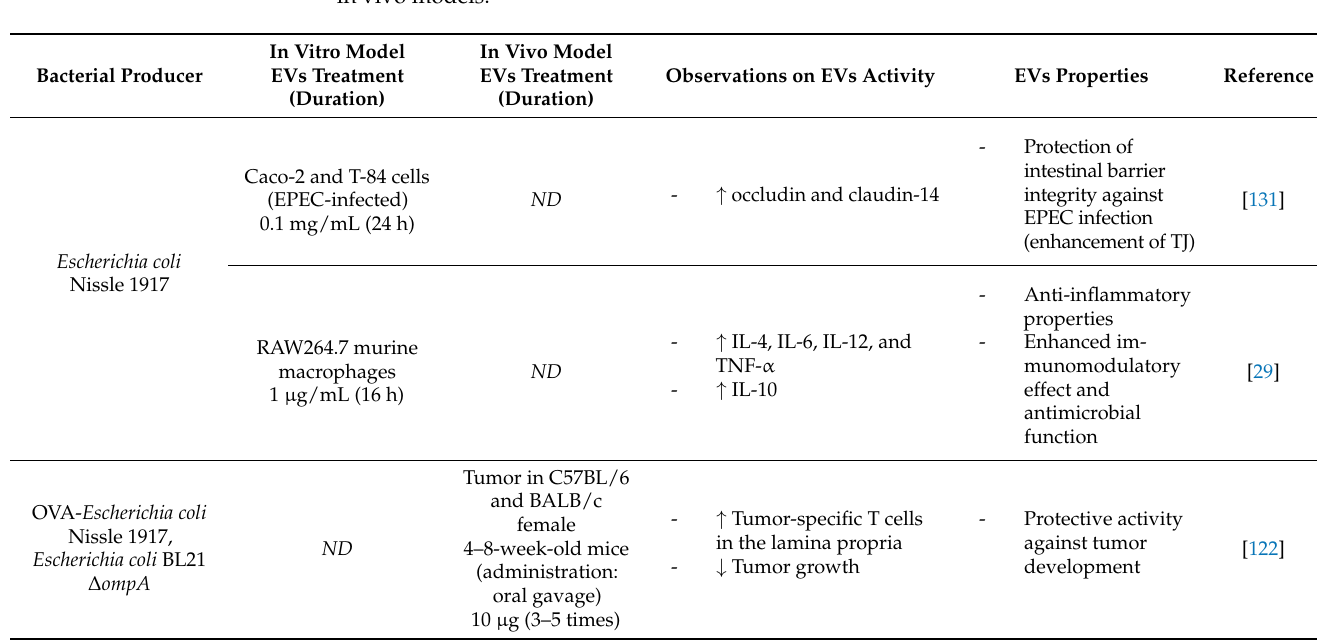
Figure 2. Graphical summary of data on the biological activities of extracellular vesicles secreted by probiotics. Table 2. Biological activity of extracellular vesicles produced by probiotics reported in in vitro and in vivo